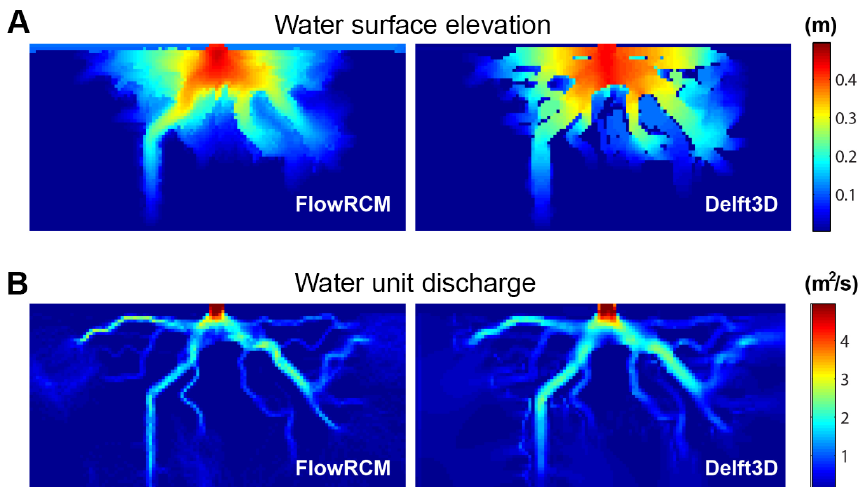
Figure 16. Results of test 4b (flow over a DeltaRCM-generated delta topography): (a) water surface elevation and (b) water unit discharge. The results obtained with DeltaRCM are compared to the results from Delft3D using the same topography and input conditions. The results show that (1) both models yield similar discharge distribution throughout the topography, and (2) both models yield similar water surface profiles in magnitude, although DeltaRCM shows a more consistent surface profile and more pronounced gradient across the channel into the